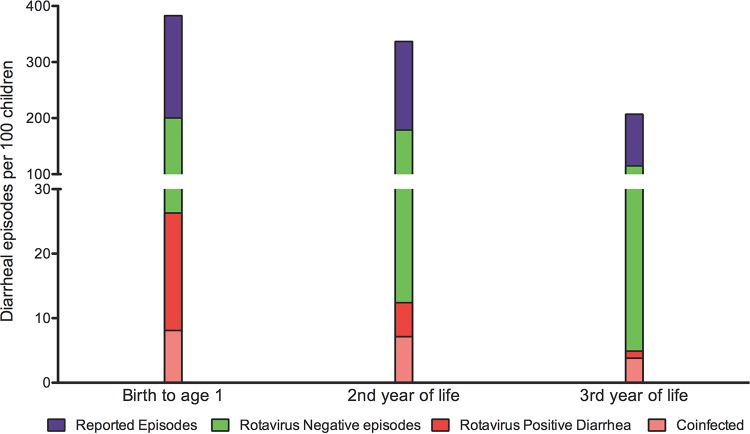
Experience with diarrhea and rotavirus-positive diarrhea in the first 3 years of life. Diarrheal surveillance data were available for 626 infants in the first year of life, 504 infants in the second year of life, and 445 infants in the third year of life. Each bar represents the total number of reported episodes per 100 infants in a given period of life. Three hundred eighty-three episodes of all-cause diarrhea were reported per 100 infants in the first year of life, 336 in the second year of life, and 206 in the third year of life. Each bar is further subdivided into the number of rotavirus-negative (green) and rotavirus-positive (red) diarrheal episodes per 100 children in a given age group. The number of coinfections with rotavirus and Entamoeba histolytica, Giardia lamblia, or Cryptosporidium parvum per 100 children is shown in pale red.